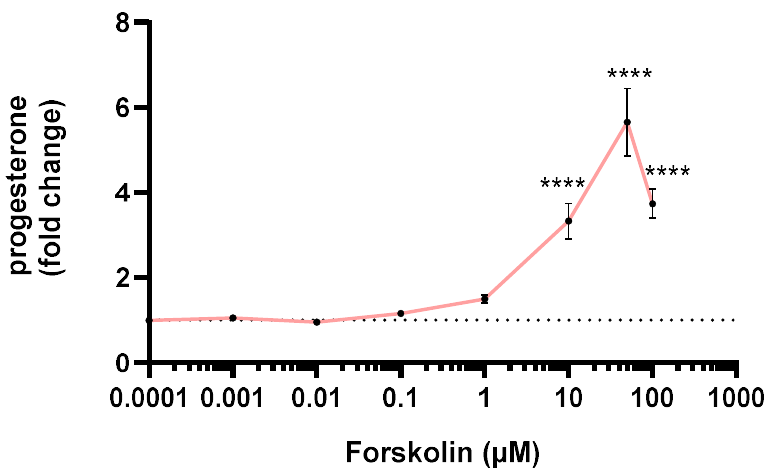
Figure 4. Progesterone secretion after a 72-h incubation time with forskolin. The dotted line represents the progesterone basal secretion. The significance threshold was **** p < 0.0001 compared to the culture medium.